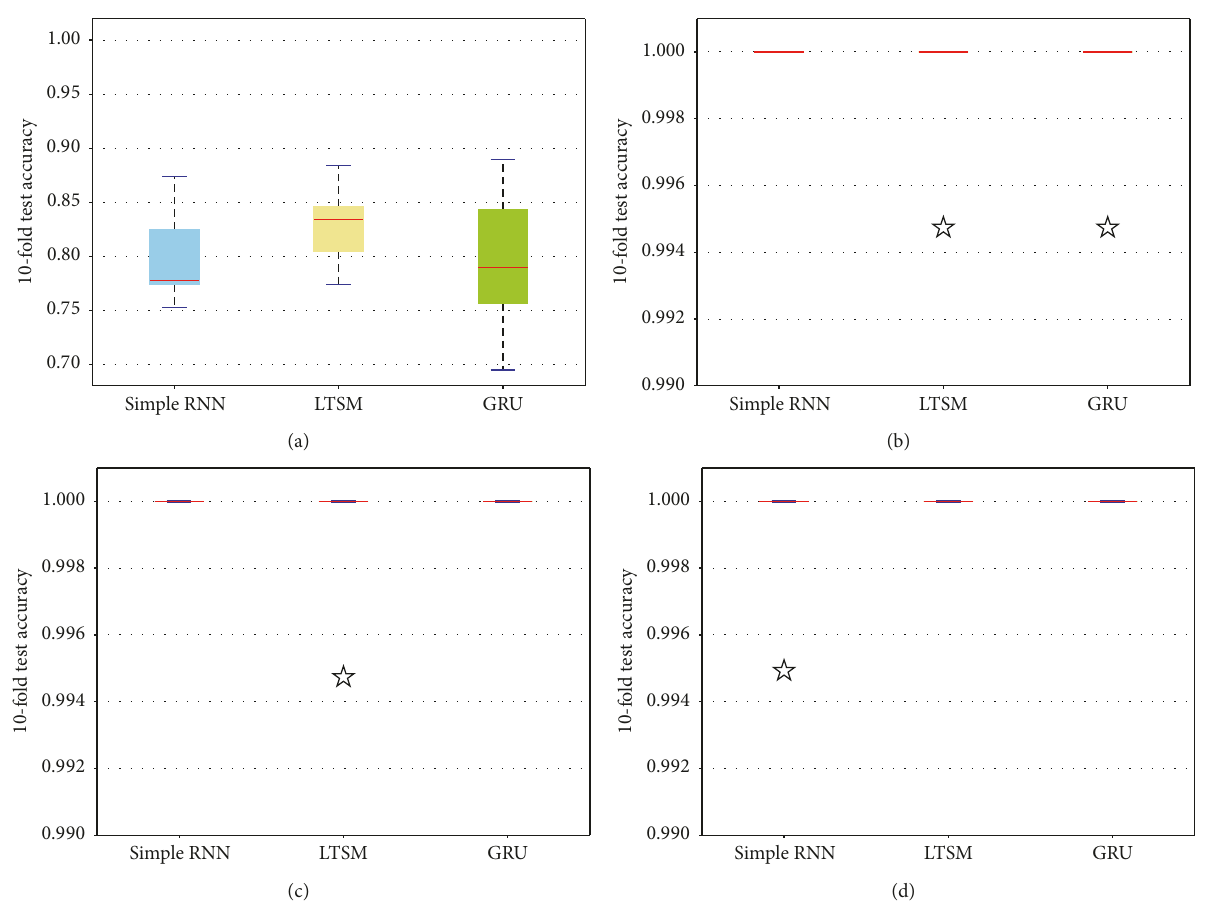
Figure 3: Effects of (a) ResNet50, (b) InceptionV3, (c) Xception, and (d) MobileNet CNN with three different RNN units on the 10-fold test accuracy. The pentagrams in (b), (c), and (d) represent the outlier of the results.